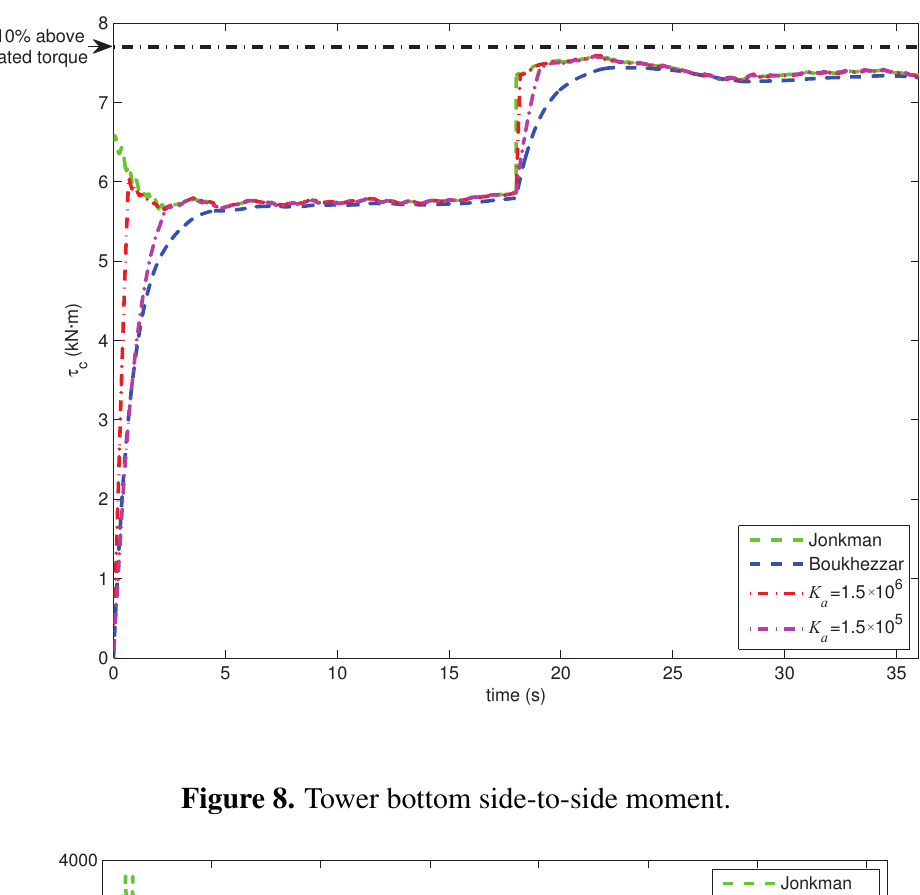
Figure 7. Torque control.